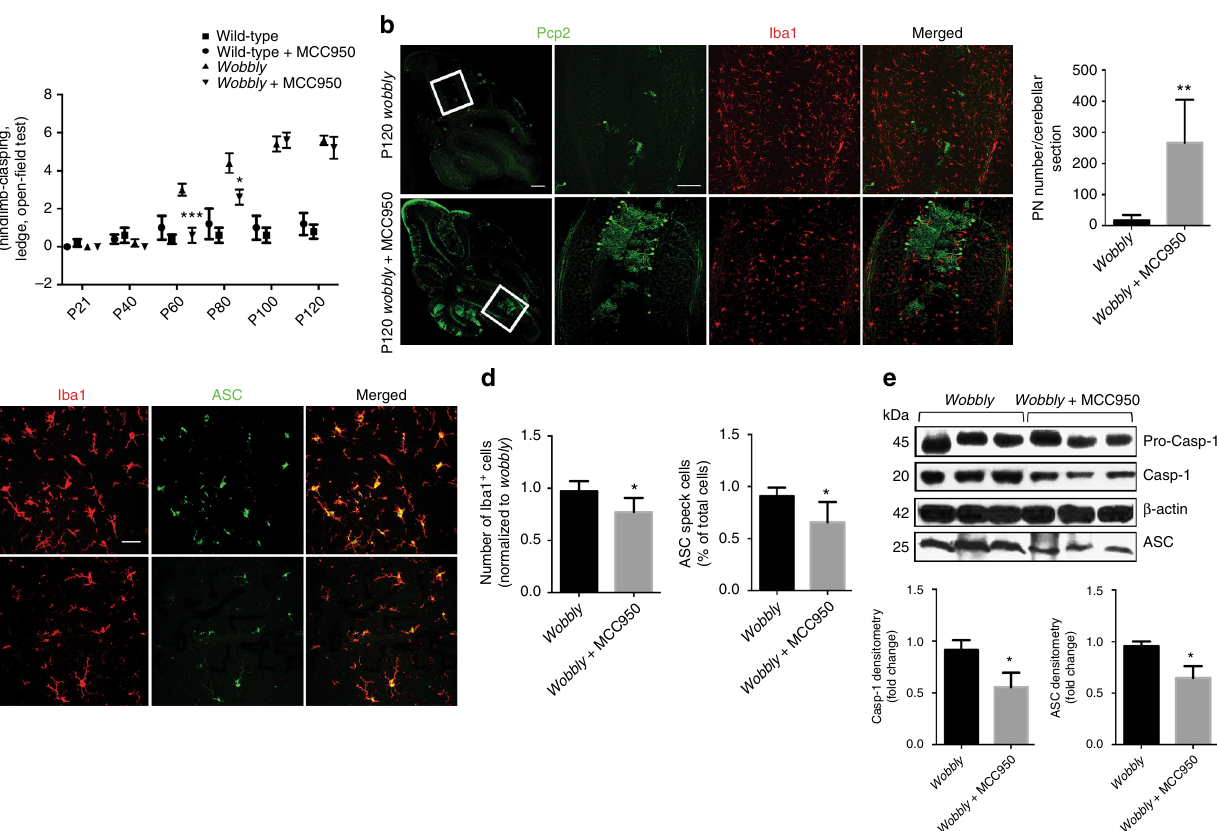
Fig. 7 MCC950 treatment delays the onset of the wobbly phenotype. a Analysis of the ataxic phenotype of wobbly and MCC950-treated wobbly and wild- type mice relative to wild-type controls ( n = 6 (3 males and 3 females) for each of the genotypes). b Pcp2 and Iba1 immuno-staining and PN quanti fi cation in P120 wobbly mice with and without MCC950 treatment. White rectangles represent magni fi ed areas. c Iba1 and ASC immuno fl uorescence on sagittal cerebellar sections of P120 MCC950-treated and untreated wobbly mice. d Quanti fi cation of microgliosis and ASC specks in ( c ). e Western blot analysis and densitometry of cleaved caspase-1 (Casp-1) and ASC in P120 MCC950-treated wobbly cerebellar brain lysates relative to the untreated wobbly controls. For ( b – e ) n = 5 for each of the genotypes; representative images and blots are shown. Scale bars: ( b ) left panel 500 μ m; ( b ) middle and right panels, 100 μ m; ( c ) 10 μ m. Statistical evaluation: ( a ) two-way ANOVA and Sidak ’ s multiple comparisons test; ( b , d , e ) two-tailed t test. Statistically signi fi cant differences are indicated ( * P ≤ 0.05; ** P ≤ 0.01; *** P ≤ 0.001). Data represent mean ±